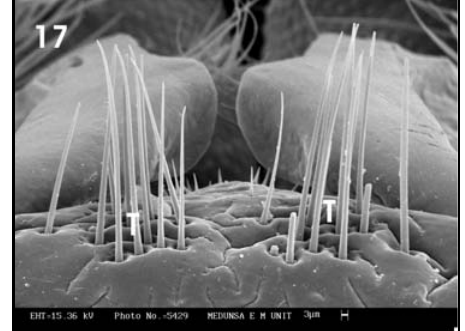
Fig. 15. The apical tip of each of each paratergite revealed a spiracular opening (SO).